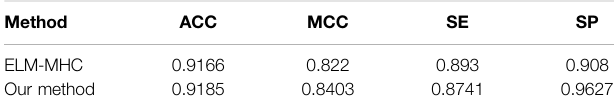
TABLE 5 | Comparison of 10-fold cross-validation with the existing method on all